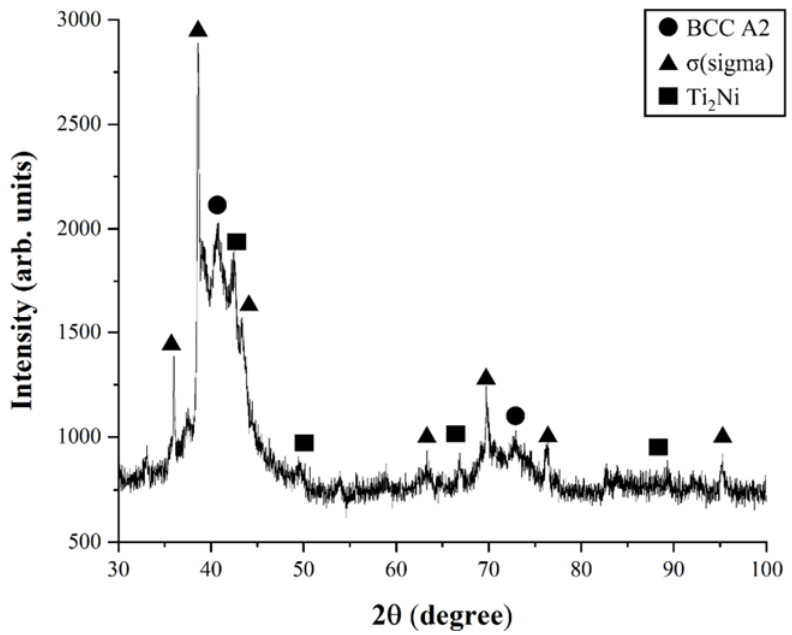
Figure 9. The results of XRD analysis of Ti ‐ Nb ‐ Cr ‐ V ‐ Ni ‐ Al. Table 4. The chemical compositions of the structure constituents for Ti ‐ Nb ‐ Cr ‐ V ‐ Ni ‐ Al. Element (at %)